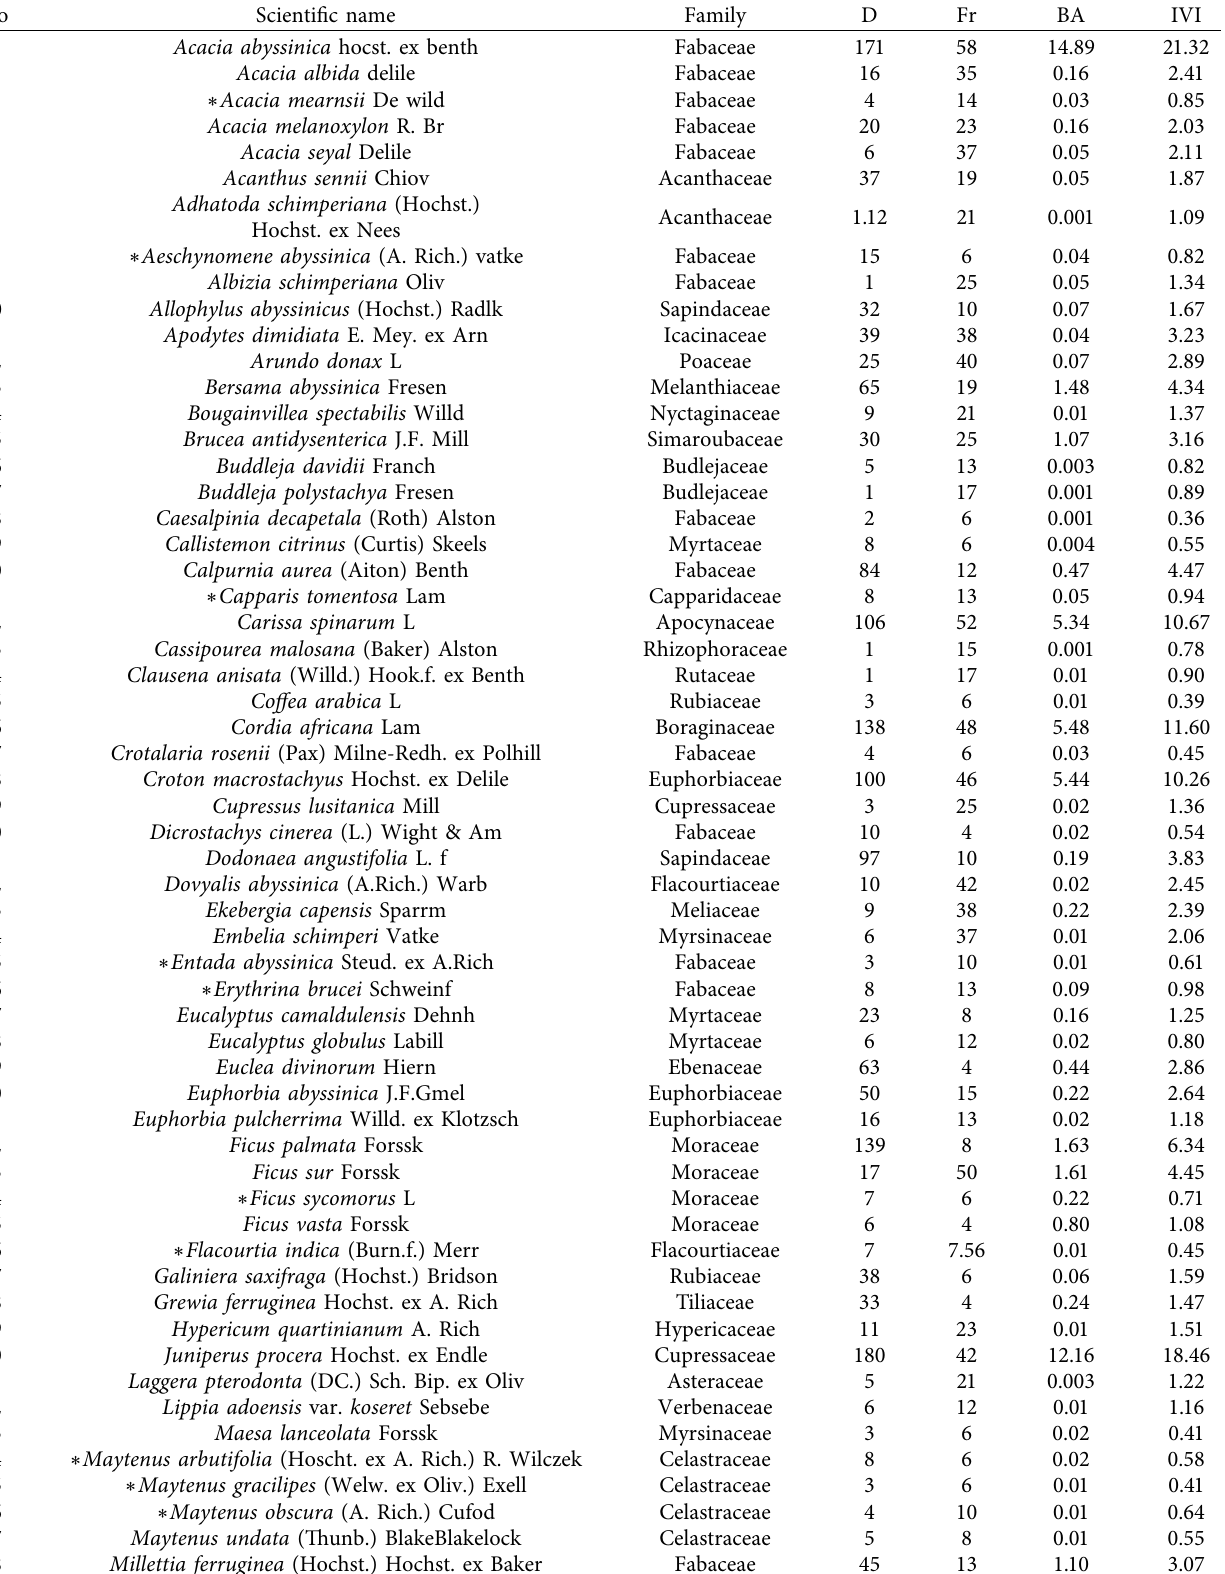
Table 1: Density (no. of stems ha − 1 ), frequency (%), basal area (dominance) (m 2 ha − 1 ) and important value index of woody plant species with DBH ≥